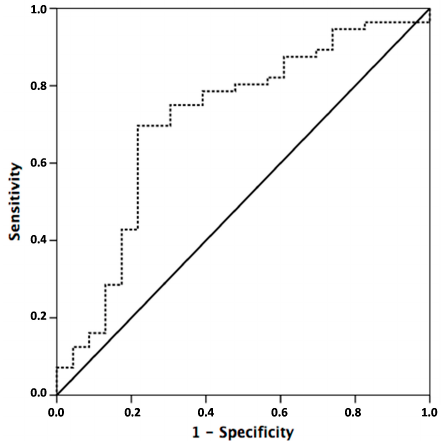
Figure 2. Receiver operating characteristic (ROC) Curve. Based on this ROC curve, the cutoff point that provides the best sensitivity and specificity to separate rectal cancer from any response to absence of response (Ryan 3) was selected. According with this criteria, miR-31 high (or overexpressed) was defined as ∆ C T miR-31 < 0.34 and miR-31 low was defined as ∆ C T miR-31 > 0.34. The dash line represents the coordinated points of the ROC curve. The solid line represents the ROC curve diagonal reference